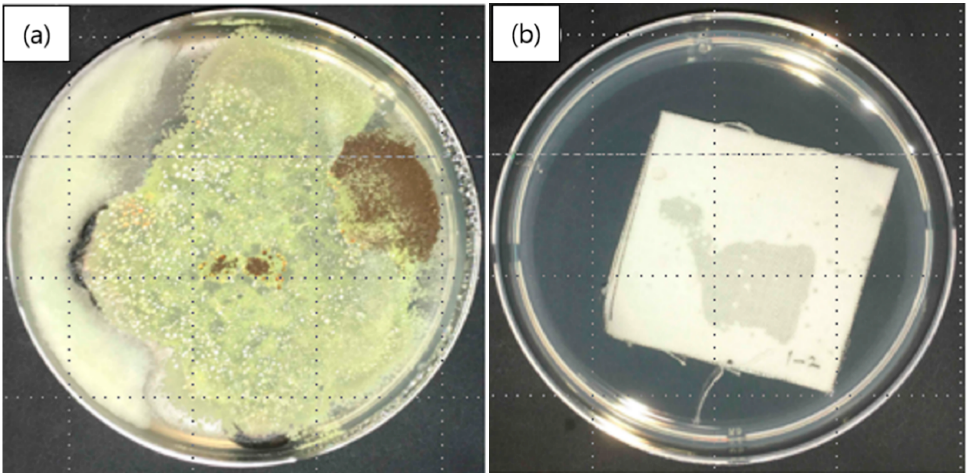
Figure 8. Antifungal activity of nanofibrous membranes containing cinnamon oil: ( a ) control specimen; and ( b ) nanofibers containing cinnamon oil.